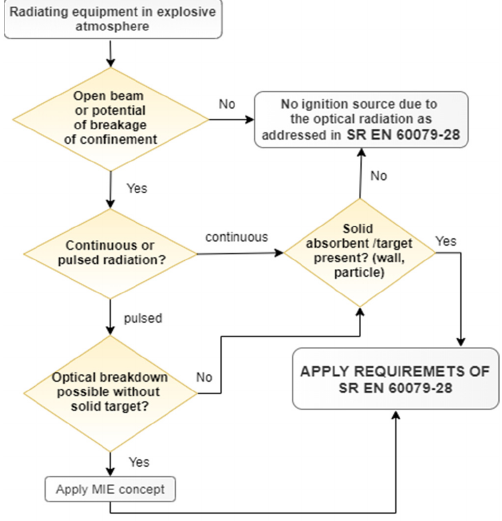
Figure 1. Ignition hazard assessment.